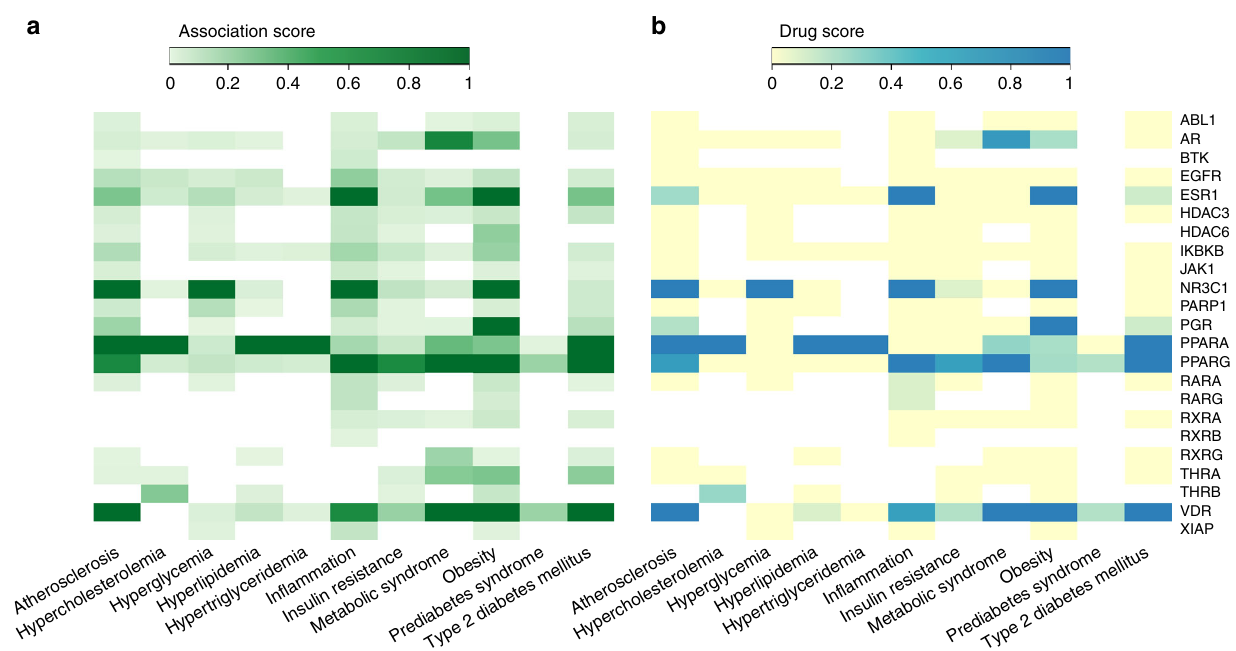
Fig. 6 Association between the active drug targets in the adipose network and MetSyn-related traits based on the scores provided by OpenTargets. a Heatmap of total association score and b heatmap of association score based on ChEMBL information about drugs approved for marketing by FDA or under evaluation in clinical trials. Source data are provided as a Source Data fi